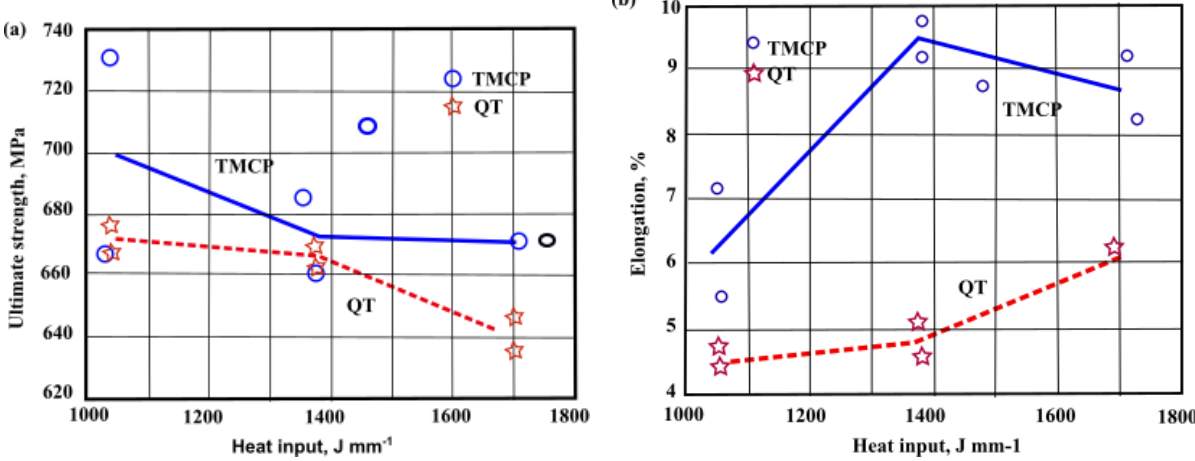
Figure 5: Heat input function of; (a) ultimate strength, (b) elongation. Reprinted with permission from Pirinen et al.// Welding International. (2015). ©2015 Tailor & Francis.